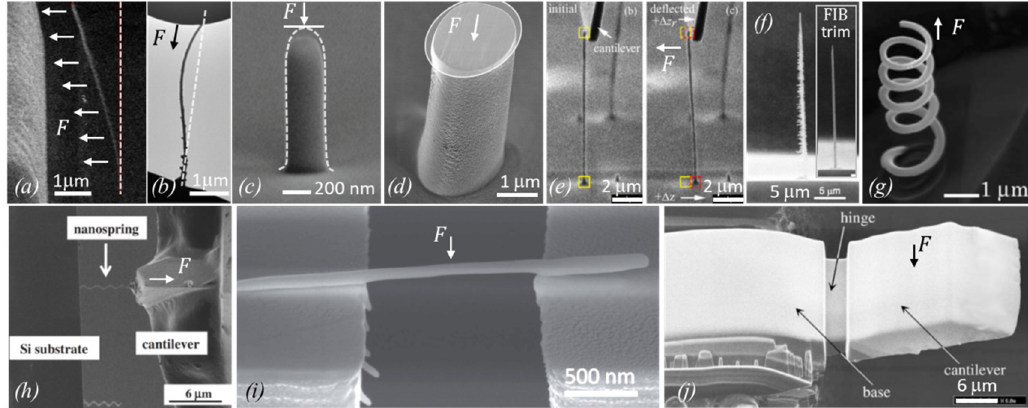
Figure 13. Overview of published metal–carbon deposit shapes and methods to determine their elastic moduli. The force F acting on the structure is indicated as well as the initial shape of the structure (dashed line). ( a ) Pt-C FEBID pillar bent within an electrostatic field toward the electrode, modified from Arnold et al. [47] . ( b ) Buckled Pt-C pillar between an actuator (top) and substrate (bottom). The initial shape was straight as indicated, modified from Hao et al. [90] . ( c ) Pt-C FEBID pillar nanocompression by a flat diamond punch (not shown), modified from Lewis et al. [48] . ( d ) FEBID Co-C pillar with Ga–FIB milled flat top for compression experiments. ( e ) Cu–C pillar bending with cantilever and pillar base image tracing, modified from Friedli et al. [53] . ( f ) FIB pillar from W(CO) 6 giving large lateral spike shapes (left), which were FIB-milled for better shape assignment in bending experiments, modified from Ishida et al. [100] . ( g ) FIB grown helix with W(CO) 6 and C 14 H 10 for tensile strain experiments, modified from Nakamatsu et al. [43] . ( h ) Tensile strain experiment with Fe-C FIB helix fixed between a cantilever and substrate, modified from Nakai et al. [59] . ( i ) FIB W-C horizontal rod three-point bending experiments, modified from Córdoba et al. [51] . ( j ) FIB grown silicon oxide structure with FIB-milled hinge geometry for bending experiments, modified from Reyntjens et al. [62] .